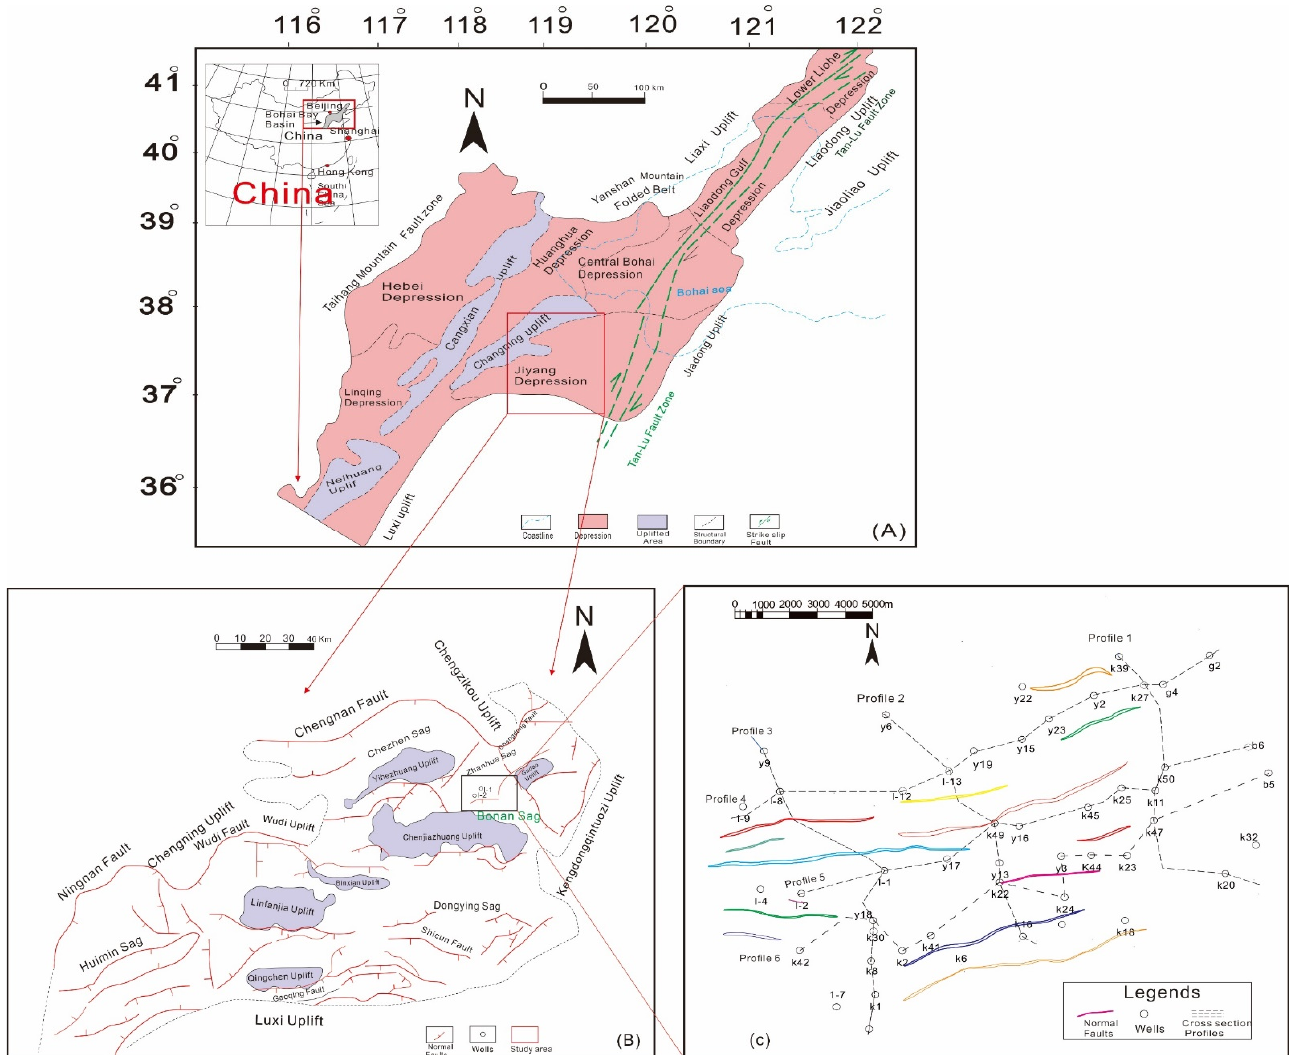
Figure 1. ( A ) Location maps of Bohai Bay Basin in China; ( B ) Structural map of Bonan Sag and associate area; ( C ) location map of the study area with detail seismic and well log